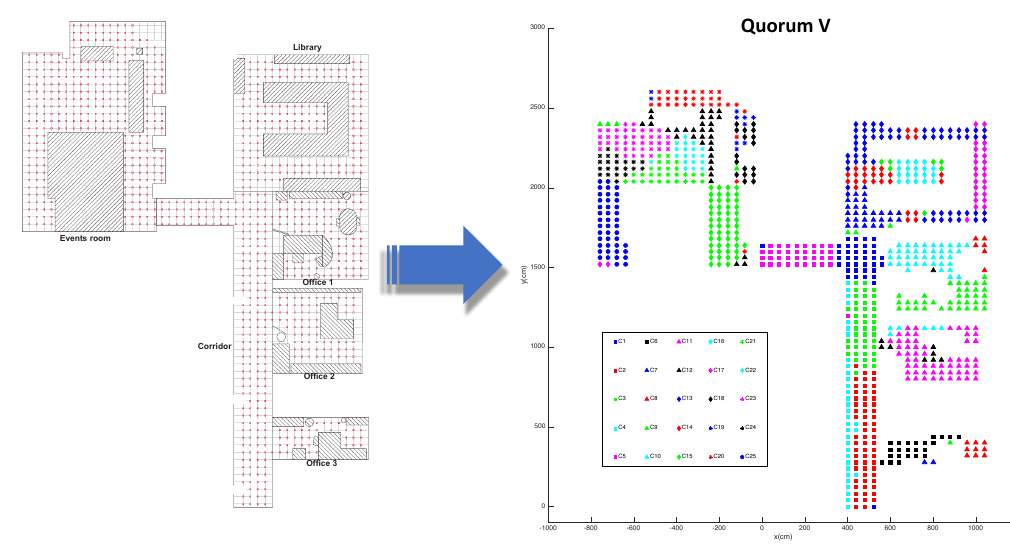
Figure 10. Quorum V environment. Cluster obtained with spectral clustering and gist description ( k 3 = 32, n masks = 16).